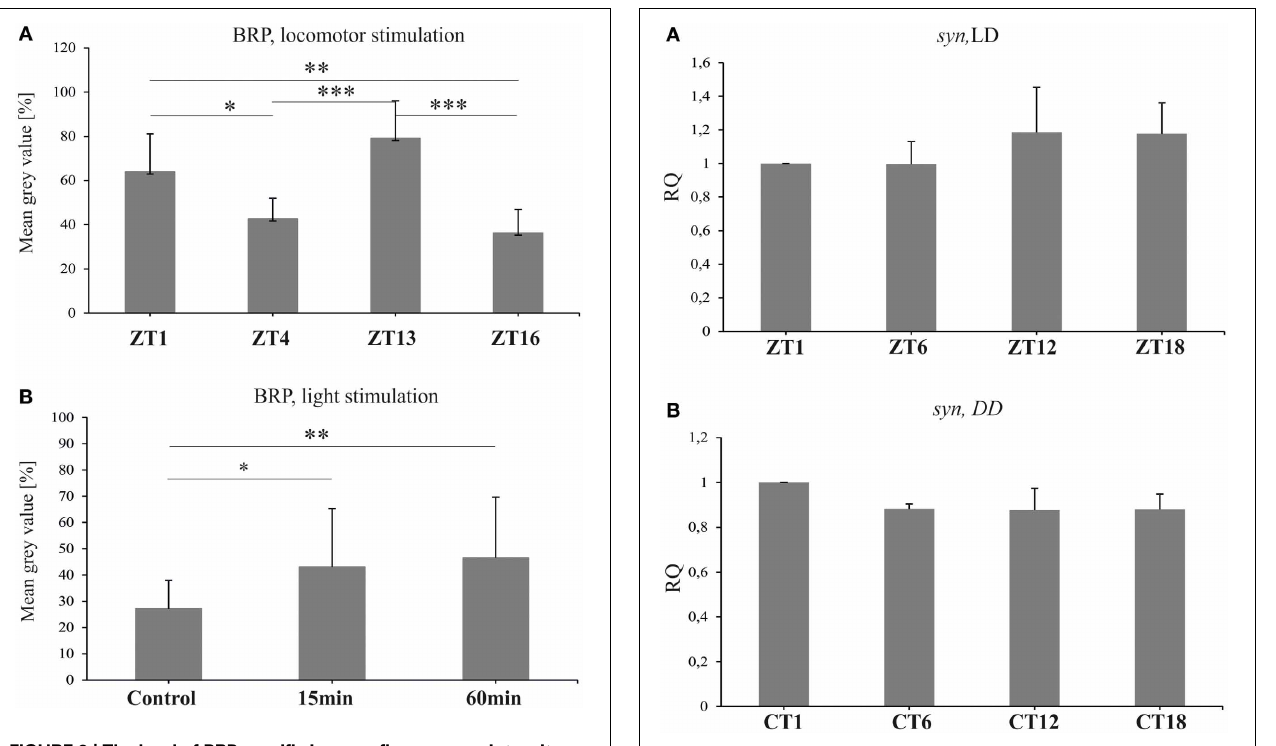
LD 12:12 (A) and in constant darkness (B). The mRNA of syn does not cycle in LD 12:12 or in